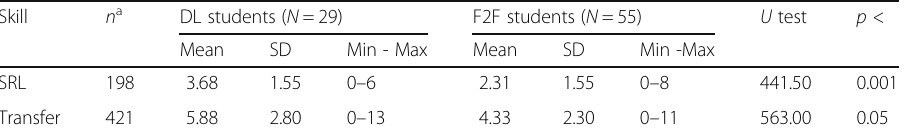
Table 2 Mann-Whitney test for SRL and Transfer components by research groups Skill n